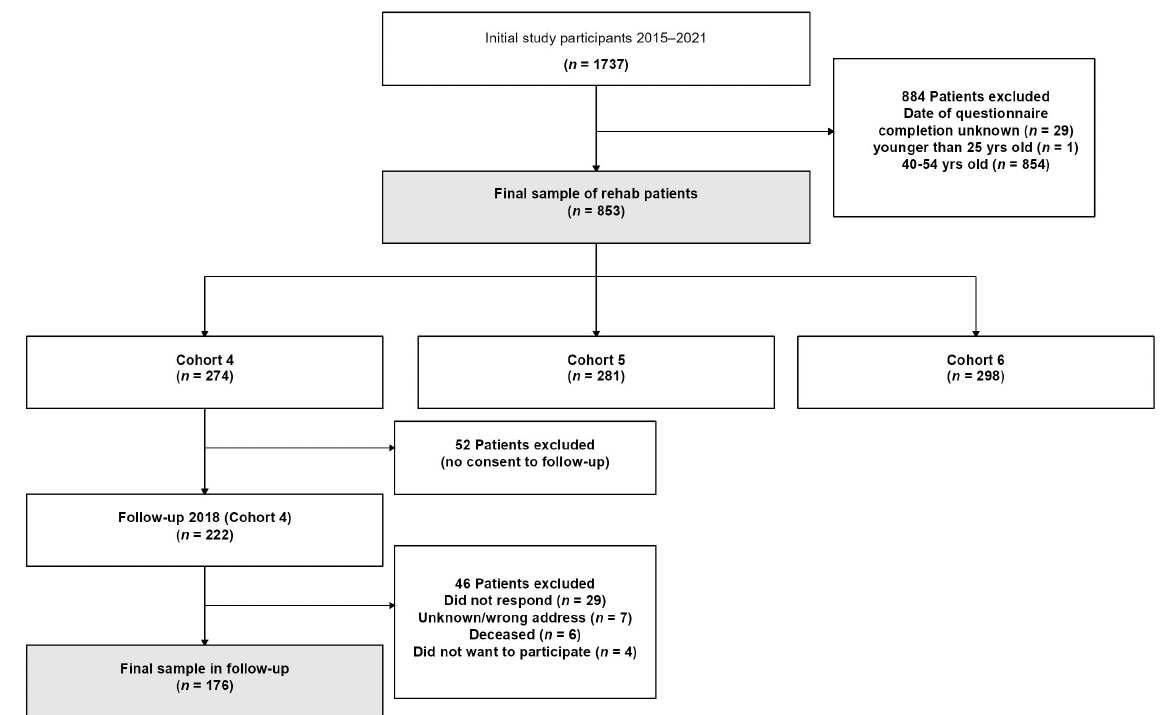
Figure 1. Flowchart of study sample for baseline survey and follow-up.